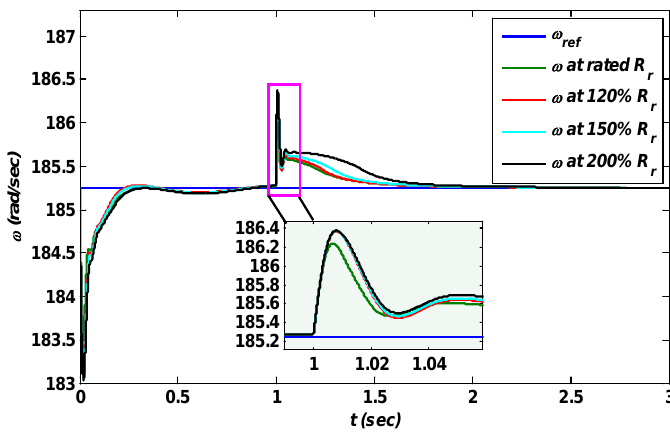
Figure 13. Speed control of IFOC IM using LM.